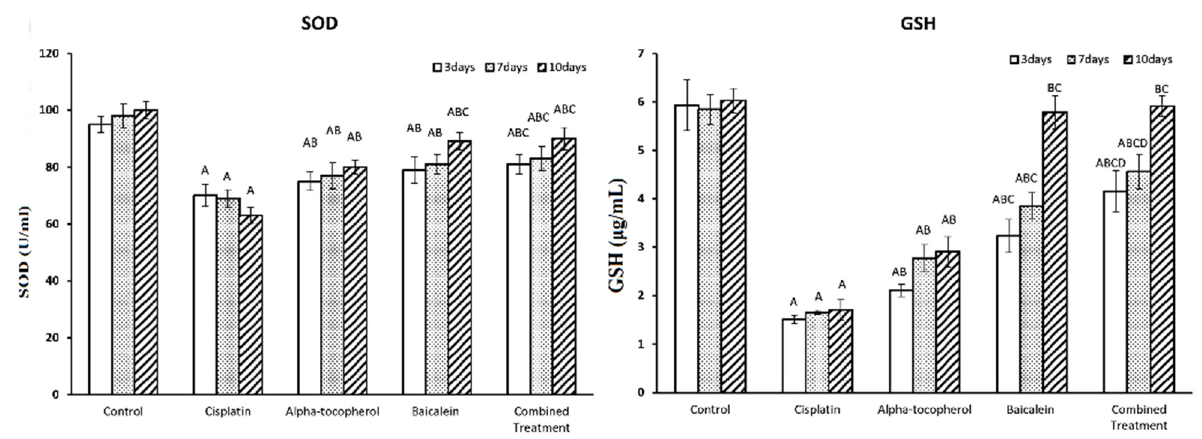
Figure 3. Effect of α -tocopherol and baicalein administration on SOD, GSH, and MDA levels in con- trol and cisplatin-treated groups. All data are expressed as mean ± SEM. Significant vs. control group refers to A, while significant vs. (cisplatin, -tocopherol, and baicalein) treatment groups refers to (B, C, D), respectively. 2.3. Effect of α -Tocopherol and Baicalein Administration on NF- κ B, IL-6, and TNF in Control and Treated Groups Figure 4 shows the assessment of the inflammation modulators such as the transcrip- tional factor nuclear factor- κ B (NF- κ B), anti-inflammatory cytokine IL-6, and proinflam- matory cytokine TNF at different periods of time (3, 7, and 10 days). There was significant increase in NF- κ B, IL-6, and TNF after administration of cisplatin. This reflects the inflam- mation induction effect of cisplatin. Upon treatment with α -tocopherol, baicalein, and combined treatment, there was a significant decrease in the TNF, IL-6, and NF- κ B in ne- phrotoxicity-induced groups. Baicalein showed better improving action than α -tocoph- erol. The combined treatment was the most effective and the nearest to the normal status.